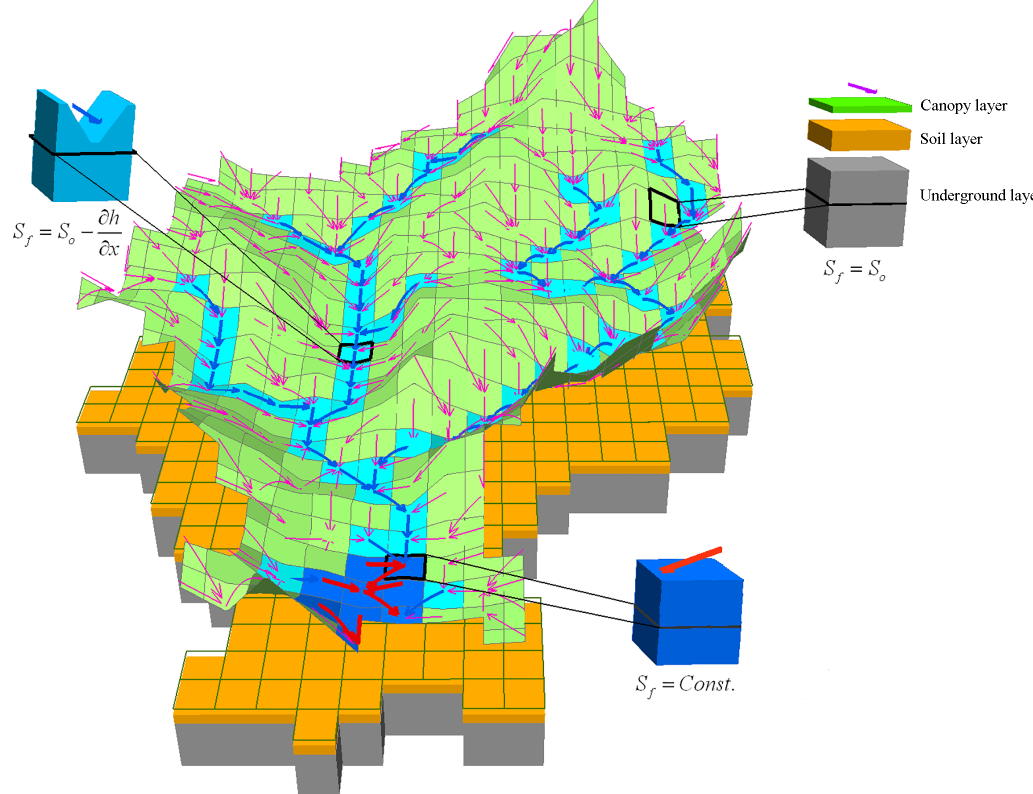
Figure 9. The structure of the Liuxihe